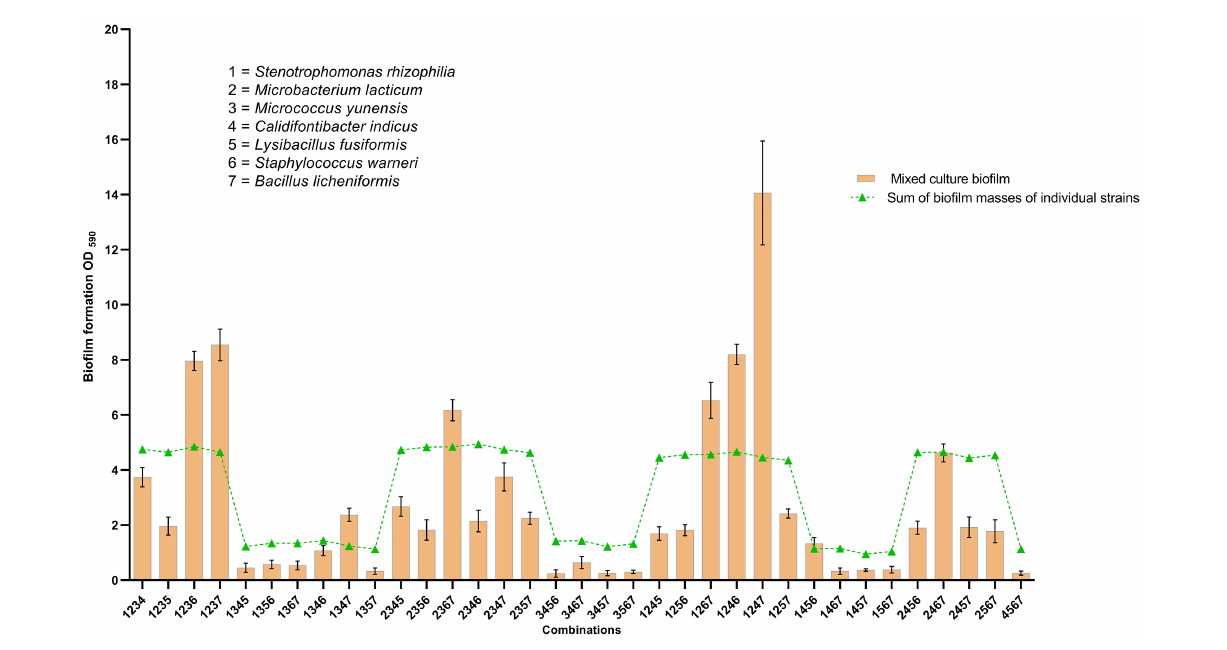
FIGURE 6 Group No. 2 comprising 7 species isolated from a milk processing industry following cleaning and disinfection. These 7 species were permutated in all possible four-species biofilm combinations (35) to find synergy in four-species biofilms. Out of 35 combinations, 8 combinations turned out to